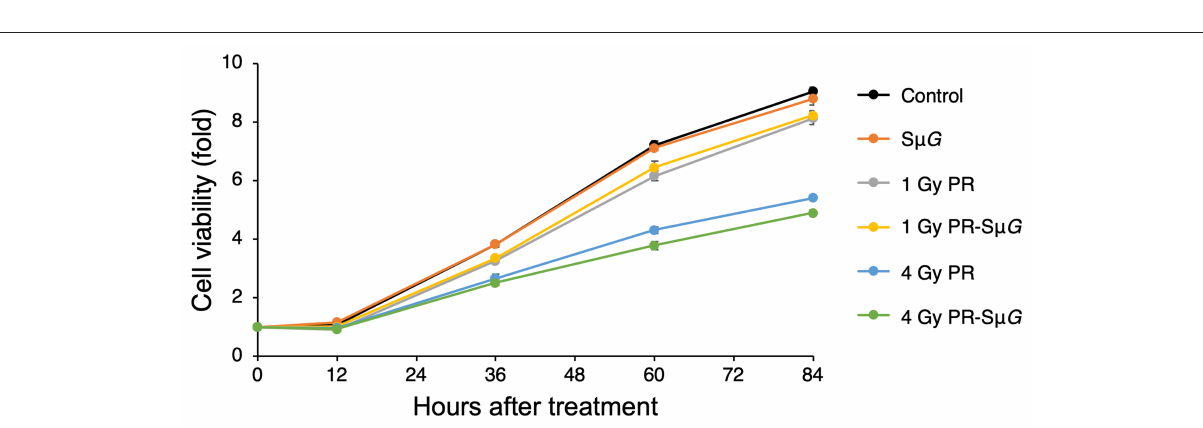
FIGURE 2 | Time course of the effects of S µ G , PR, and their combination on cell viability. Symbols: control (black closed circles), S µ G (orange closed circles), 1Gy PR (gray closed circles), 1Gy PR-S µ G (yellow closed circles), 4Gy PR (blue closed circles), and 4Gy PR-S µ G (green closed circles). The bars indicate the standard errors calculated using data from three independent